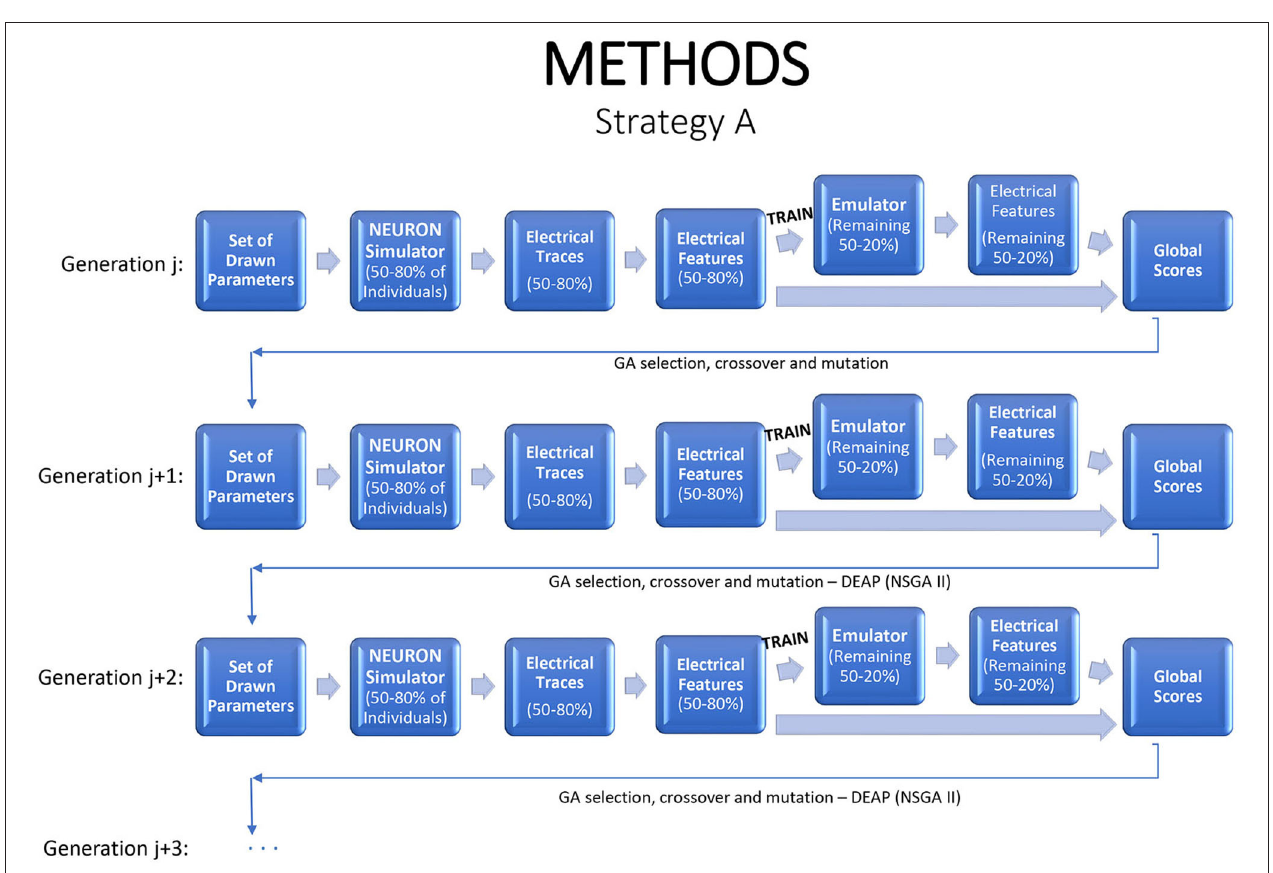
FIGURE 2 | A strategy for a modified genetic algorithm, simulating features for 80% of the individuals, using them to fit an emulator, and replacing the simulator runs by emulator predictions for the remaining 20%.